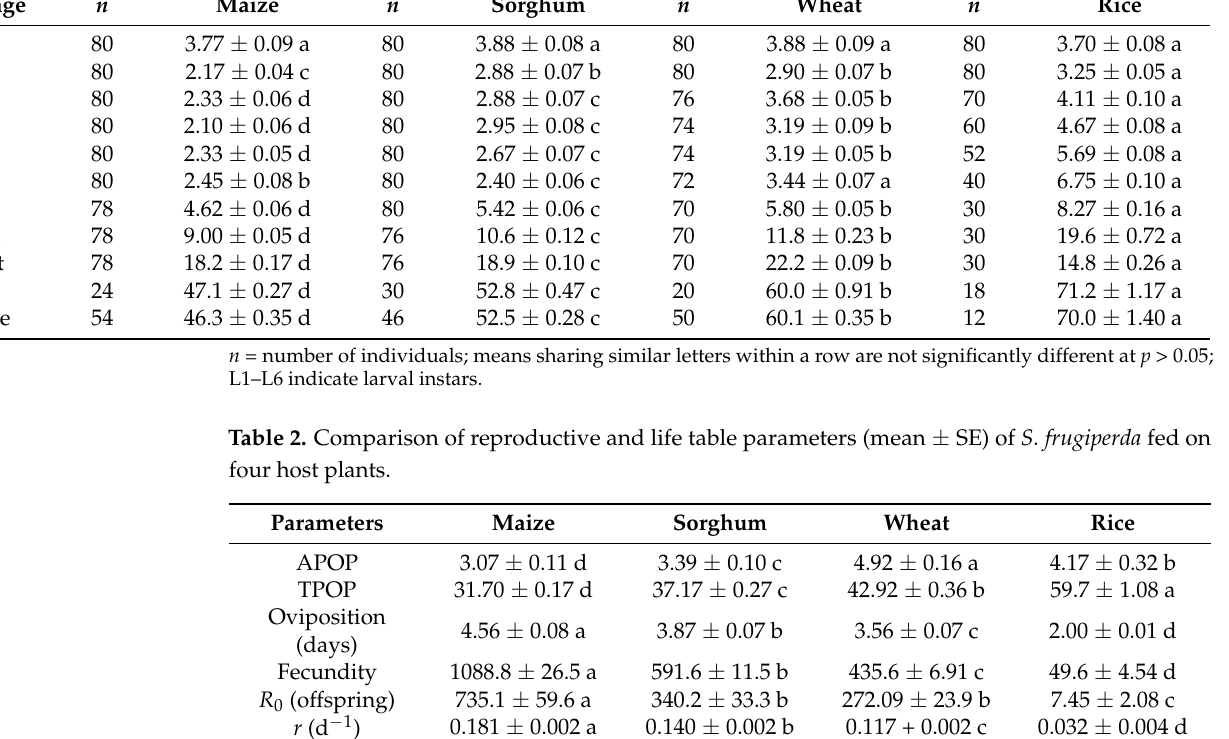
Table 1. Development time (days) of (mean ± SE) S. frugiperda raised on different hosts.